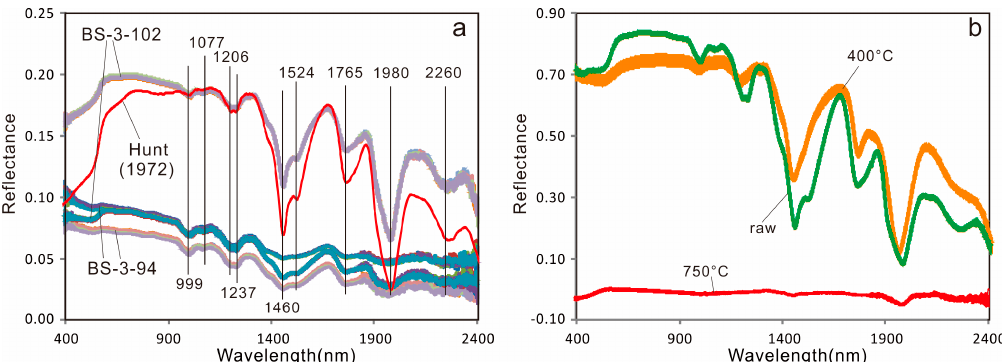
Figure 5. ( a ) Spectral comparison among carnallite samples BS-3-94, BS-3-102, and Hunt (1972) [12]; and ( b ) spectral comparison between raw and heated carnallite samples. Note that the reflectance values of the carnallite sample from Hunt (1972) [12] were divided by fourfor clarity.